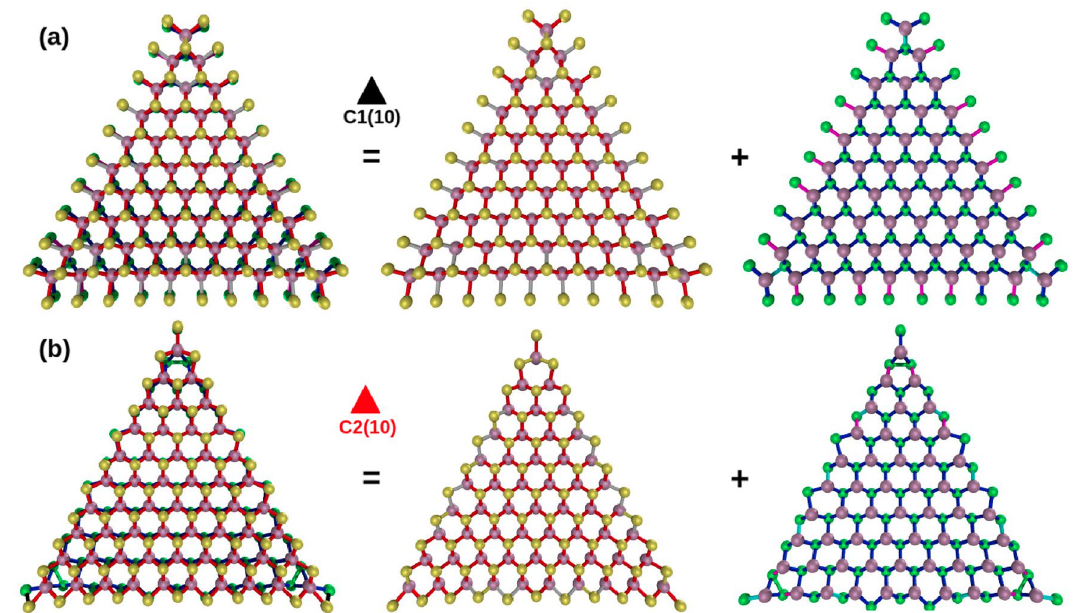
Figure 3. Bond length distribution of the stablest S/Se terminations. The image at the left is formed by the combination of adjacent images where each face is shown ( a ) C1(10) and ( b ) C2(10). S, Se, and Mo atoms are depicted as yellow, green, and violet